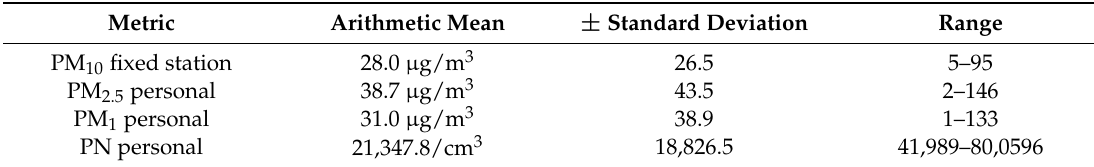
Table 1. Exposure to particles during